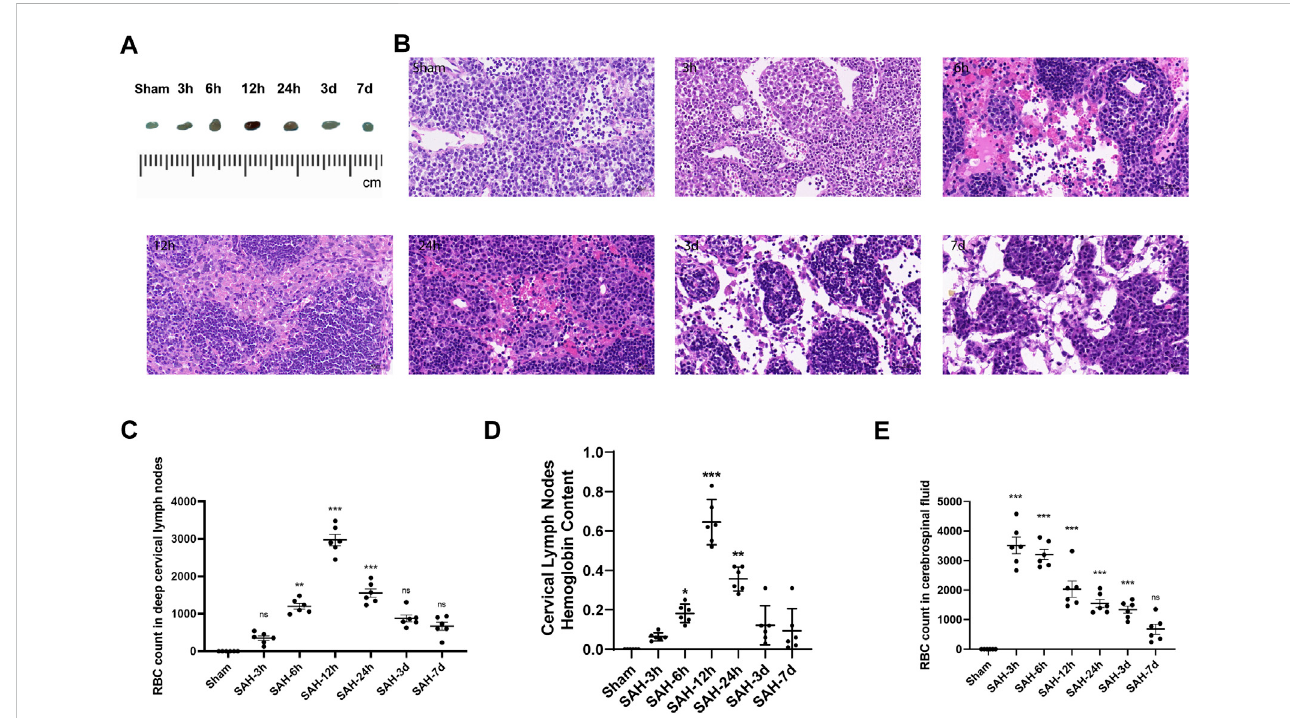
FIGURE 3 Time-courseaccumulationofRBCsindCLNsafterSAH. (A) GrossappearanceofdCLNsafterSAHatdifferenttimes. (B) HEstainingofdCLNsafterSAHat different times. The erythrocyte accumulation in dCLNs obviously increased 12 h after SAH. (C) Quantitative analysis of the RBC count in deep cervical lymph nodes at different times ( n = 6 mice, ** p < 0.01, and *** p < 0.001). (D) Hemoglobin content analysis of dCLNs after SAH at different times. Data are presented as the mean ± SD ( n = 6 mice, * p < 0.05, ** p < 0.01, and *** p < 0.001). (E) Quantitative analysis of the RBC count in cerebrospinal fl uid at different times ( n = 6 mice and *** p <